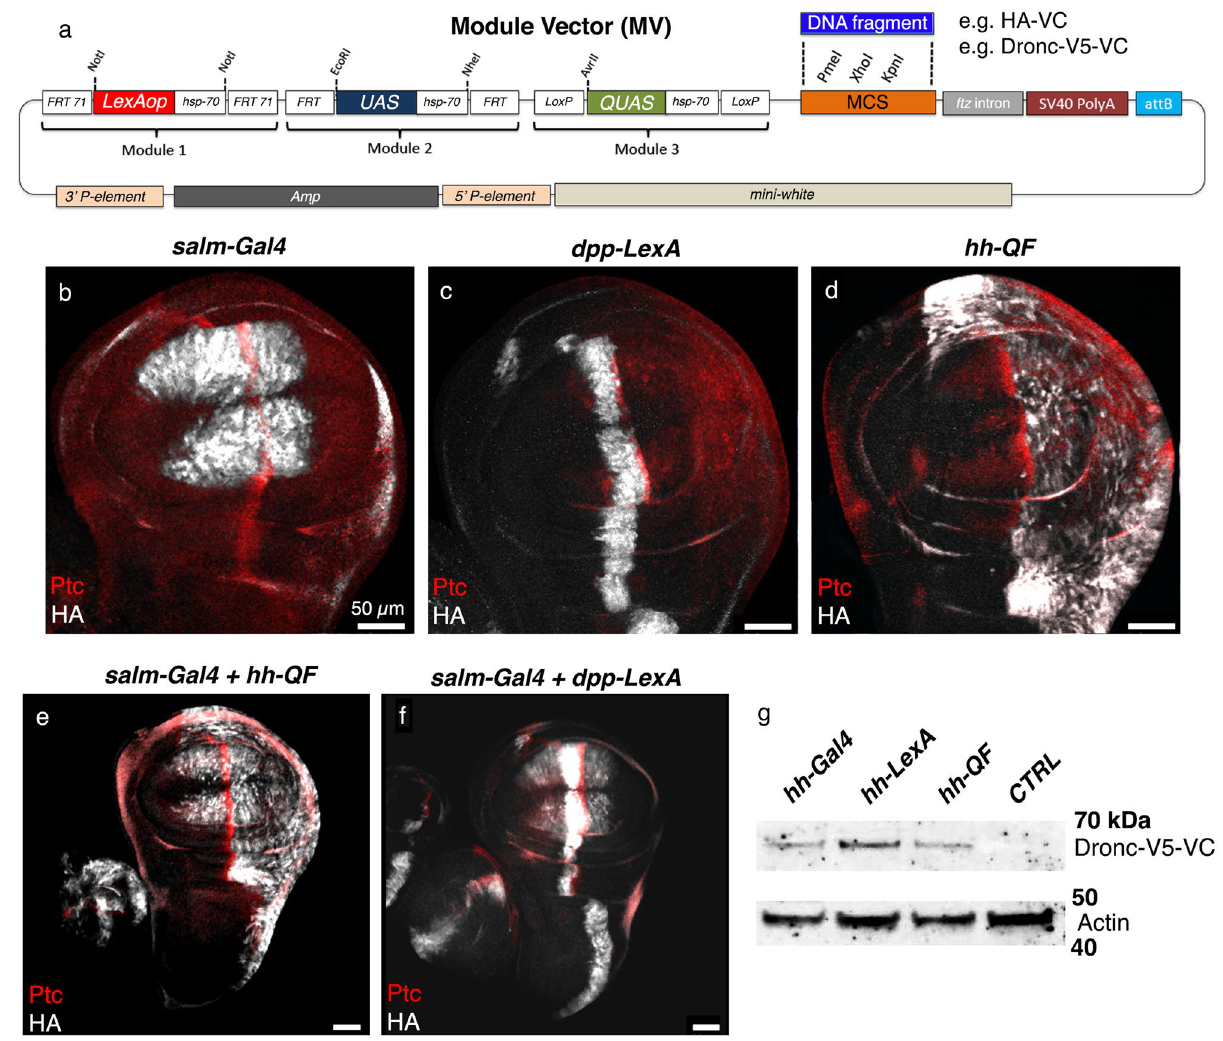
Figure 1. Features of the new Modular Vector ( MV ). ( a ) Schematic showing the different features incorporated into the modular vector ( MV ). ( b–d ) Expression of HA-VC (anti-HA immunostaining, gray) within discrete cellular domains of the wing disc under the regulation of different transcriptional activators. ( e–f ) Concomitant expression of HA-VC in several cellular domains of the wing disc under the regulation of two